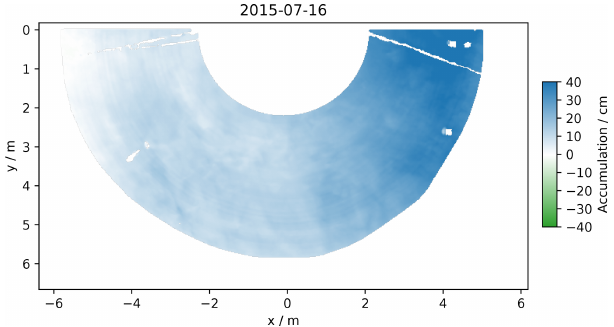
Figure 7. Accumulation between 4 and 16 July